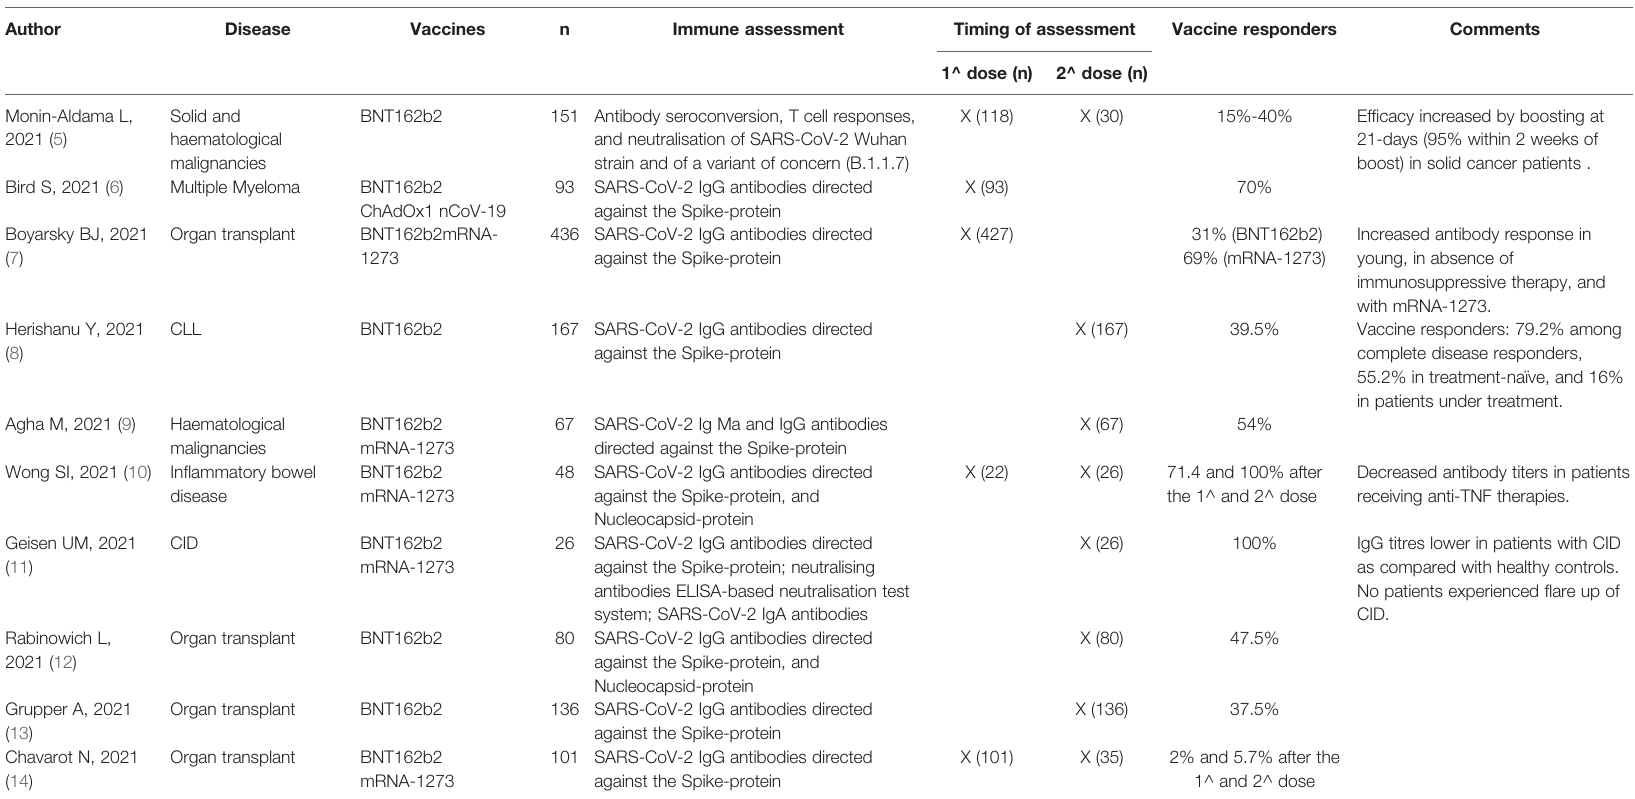
TABLE 1 | Immune responses of fragile patients: current